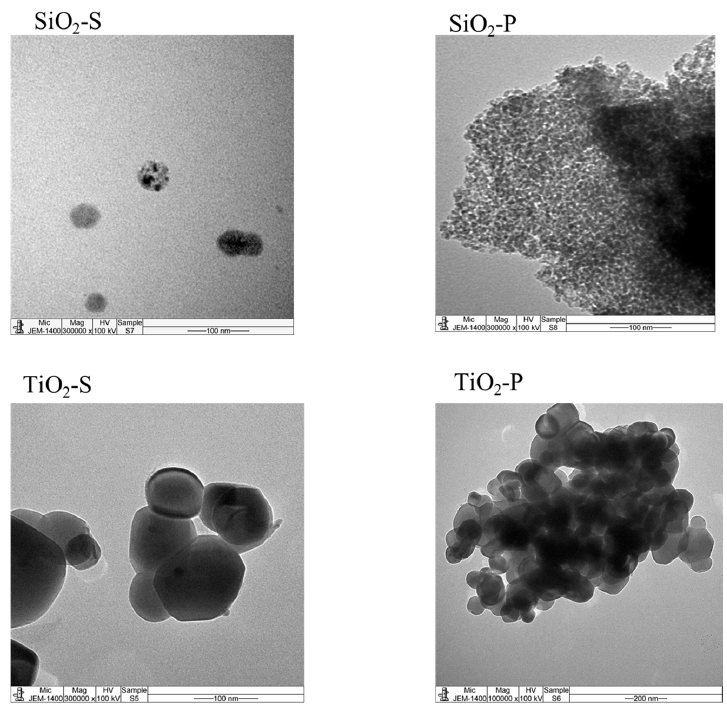
Figure 4. Transmission electron micrographs of sulfated silica, phosphated silica, sulfated titania, and phosphated titania.